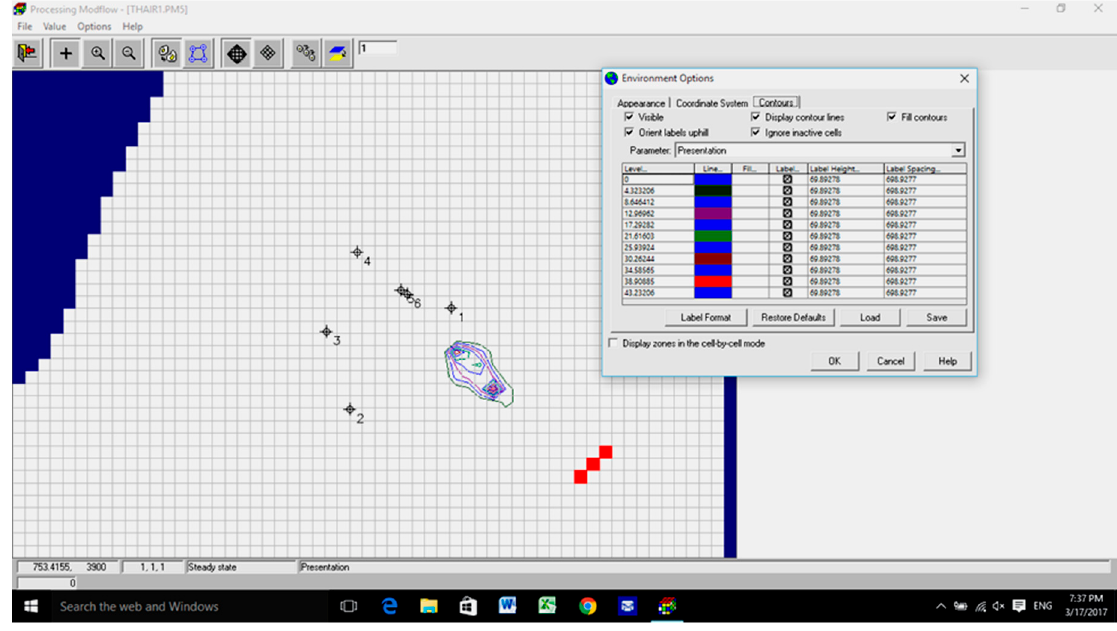
Figure 10. The extent of Co-60 pollutant concentrations from the LAMA area after five years for Scenario 2.